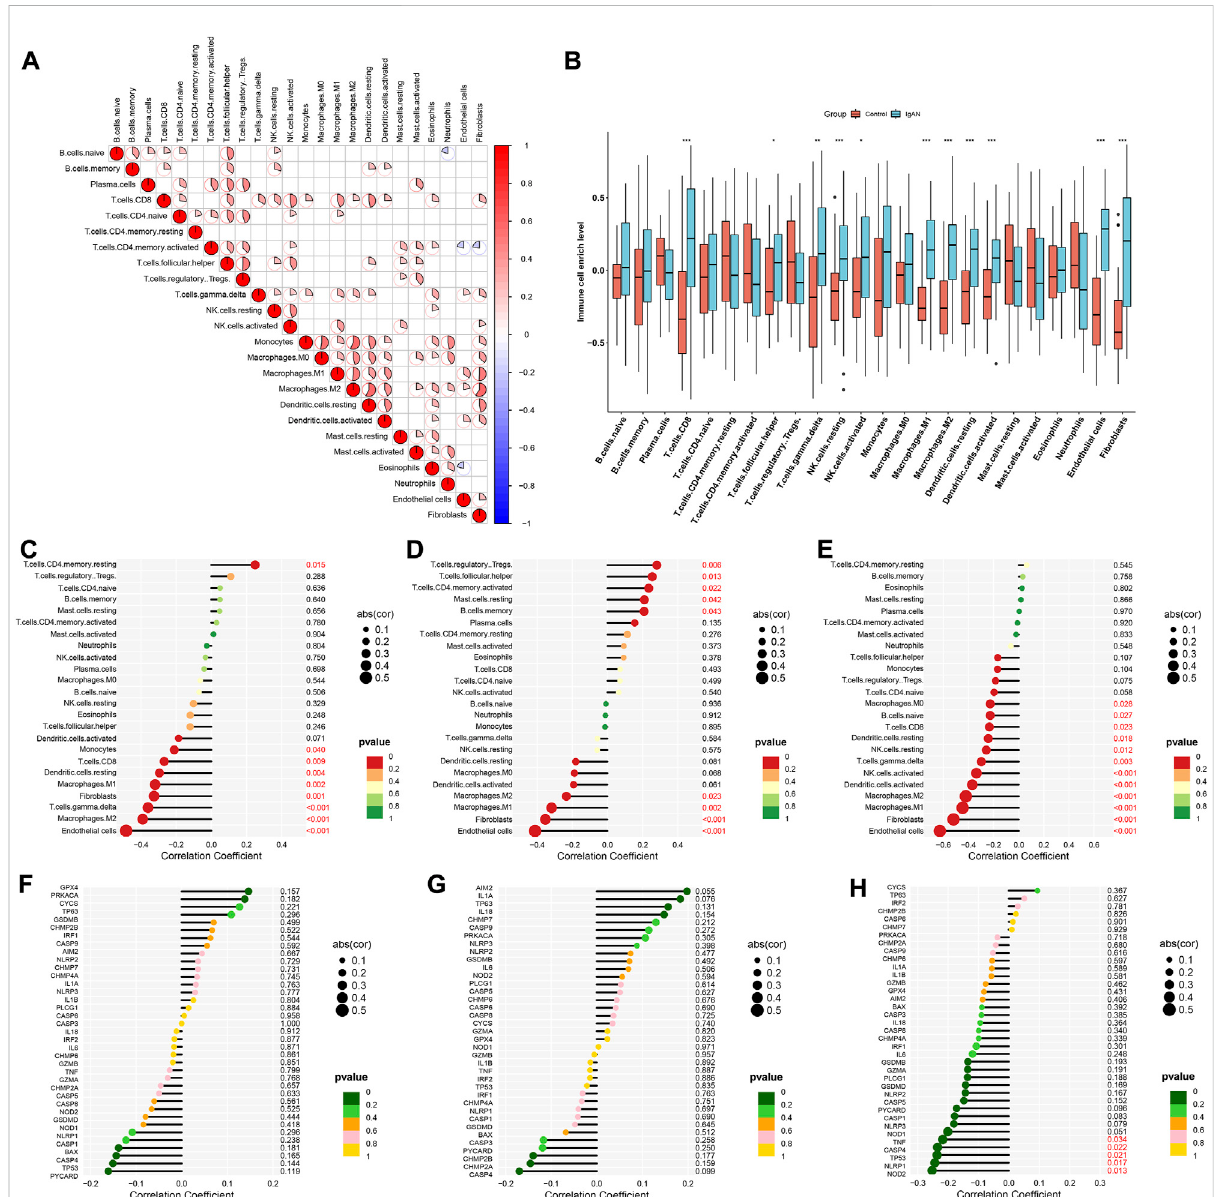
FIGURE 5 Characteristic RBPs are linked to immune cell in fi ltrations in IgA nephropathy. (A) Correlations between 24 immune cell types in IgA nephropathy specimens. (B) Enrichment levels of 24 immune cell types in IgA nephropathy and normal specimens (* p < 0.05; ** p < 0.01; *** p < 0.001). (C – E) Associationsof (C) DDX27, (D) RCL1,and (E) TFB2Mwithenrichmentlevelsofeachimmunecelltype. (F – H) Relationshipsof (F) DDX27, (G) RCL1, and (H) TFB2M with the expression of pyroptosis-relevant genes. IgAN, IgA